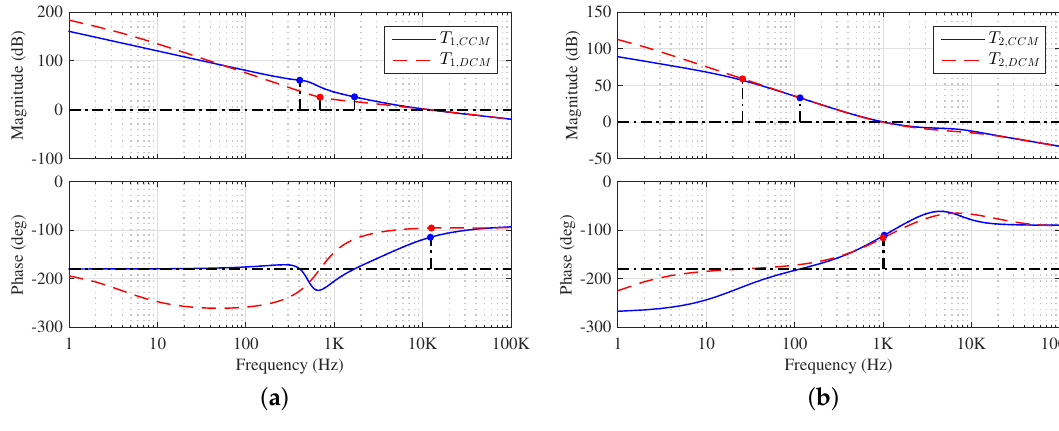
Figure 15. Bode plots of ( a ) T 1 ( s ) and ( b ) T 2 ( s ) with gain and phase margins when P dev , net >